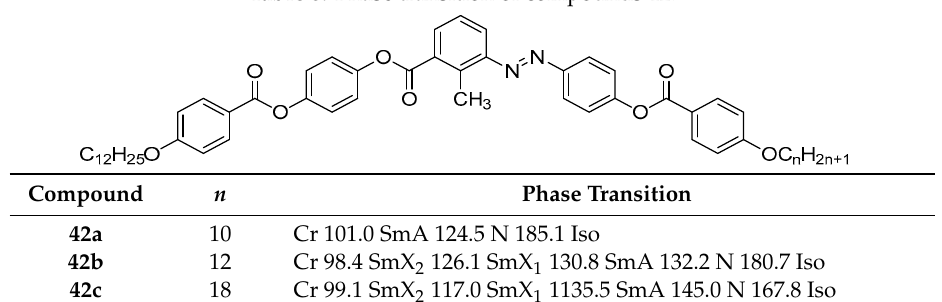
Figure 11. POM textures of compound 42c obtained on cooling from the isotropic: ( a ) the unidentified SmX 1 phase at T = 120 °C and ( b ) the unidentified SmX 2 phase at T = 105 °C [120]. Table 8. Phase transition of compounds 42 . Table 8. Phase transition of compounds 42 .